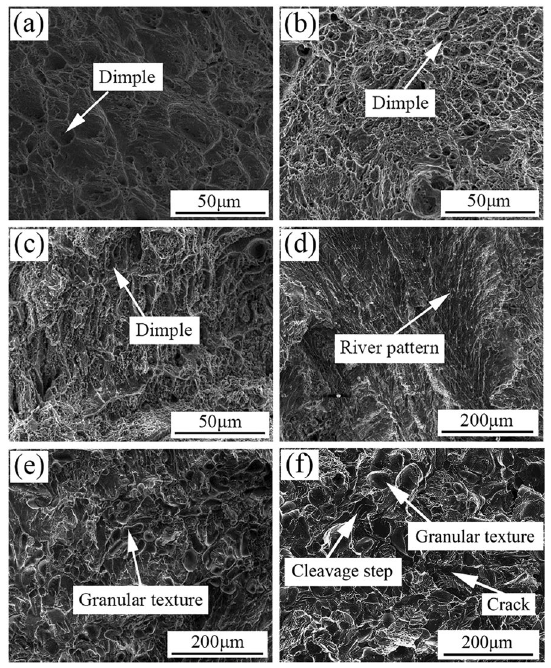
Figure 6 Fracture surfaces of SAC305 solders at 10 − 3 s − 1 under different temperatures [38]: ( a ) 25 ℃ , ( b ) 150 ℃ and ( f ) 196 − −